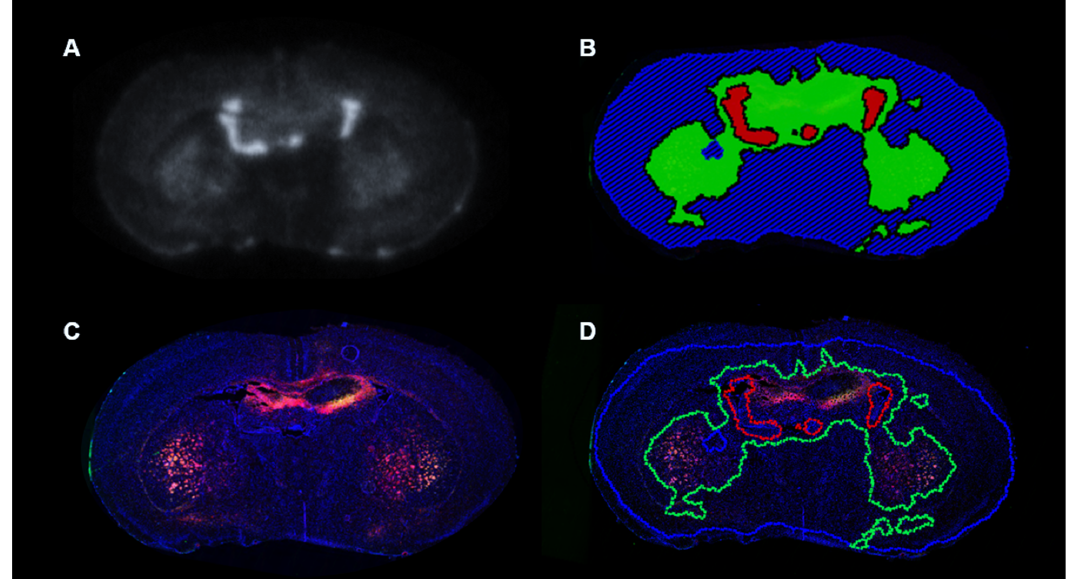
Figure 6. Analysis of autoradiography (AR) and immunofluorescence (IF) images with CD11b and F4/80 staining. Autoradiography image ( A ) was registered to the neighboring images co-stained with CD11b and F4/80 antibodies ( C ) via affine registration using Viziopharm Tissue Align. Images were segmented into low uptake (blue), increased uptake (green), and high uptake ventricle (red, excluded for analysis because uptake is excretion related) regions ( B ), which were utilized to define the ROIs in the IF images ( D ). Positive cell density for CD11b and F4/80 staining was measured in the increased 18 F-PBR-111 uptake regions (Green, CC, S, and H) and background (surrounding blue).